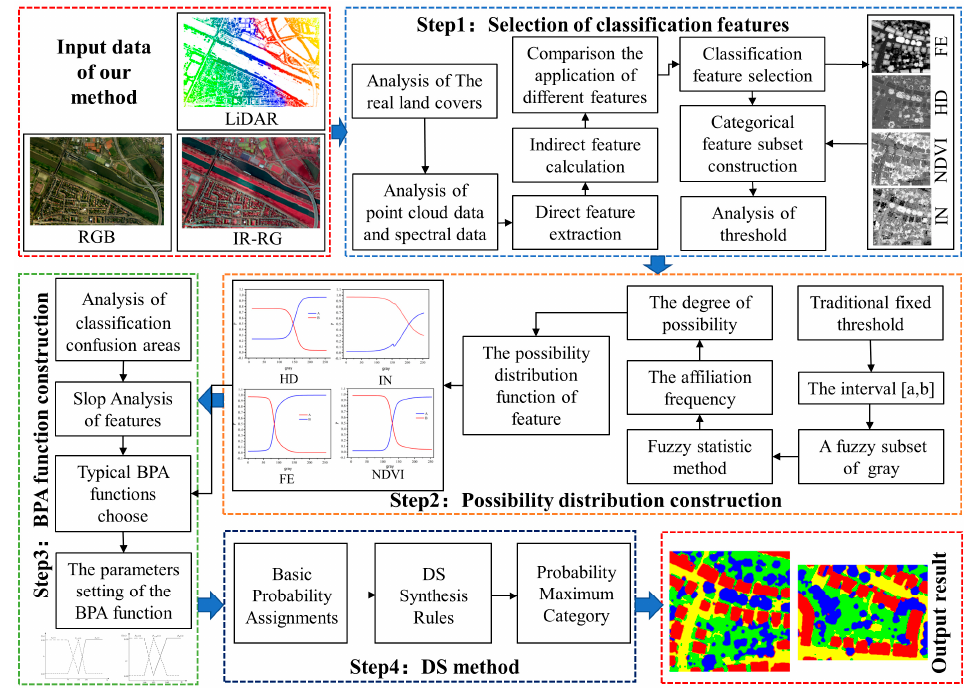
Figure 1. Workflow of the proposed